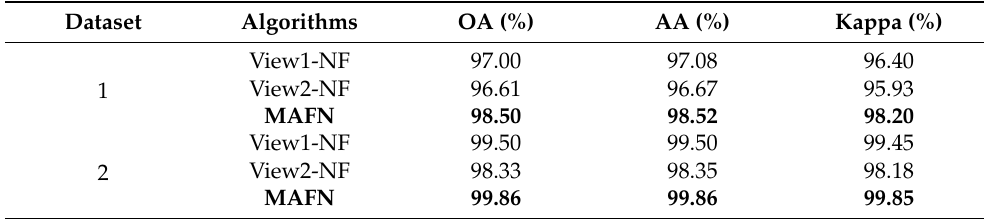
Table 2. The identification results of View1-NF, View2-NF, and MAFN on the two datasets.